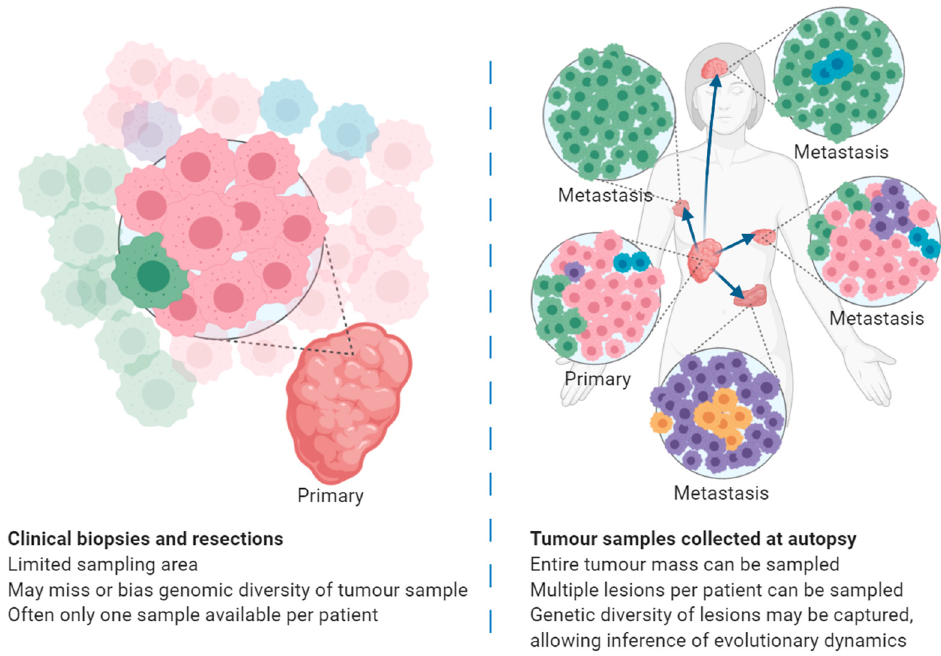
Figure 1. Demonstration of tumour heterogeneity as captured by small clinical biopsies and resections ( left ) compared with tumour samples collected at autopsy ( right ). Cancer cells are coloured by genomic similarity, where cancer cells of the same colour share the same set of genomic changes. In small cancer samples, such as those collected during clinical biopsy and resection procedures, the sample may or may not capture all genetic variations present in that tumour at that time point, and provides no information about other tumours around a patient’s body. Comparatively, tumour samples collected at autopsy may encompass larger or complete tumours and cover the primary tumour and all metastases present in the patient, allowing for genomic analyses comparing the genomic changes present in each sample. To validate different evolutionary models and patterns, it is essential to study multiple tumour samples from tumour sites around a patient’s body, usually only feasible on tumour samples collected at